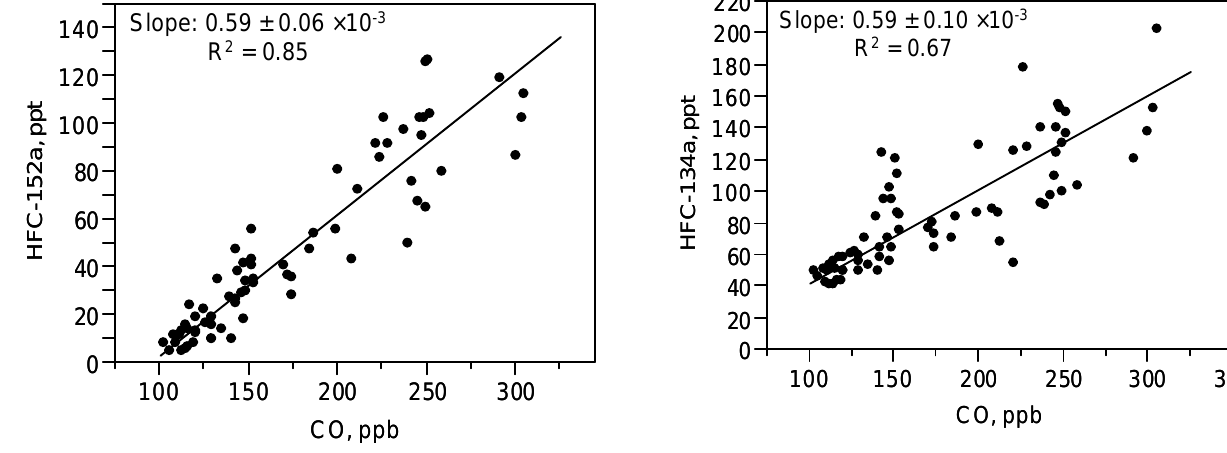
Fig. 8. Mixing ratios of HFC-134a versus CO for the samples col- Figure 8. Mixing ratios of HFC-134a versus CO for the samples collected over the LA area. lected over the LA